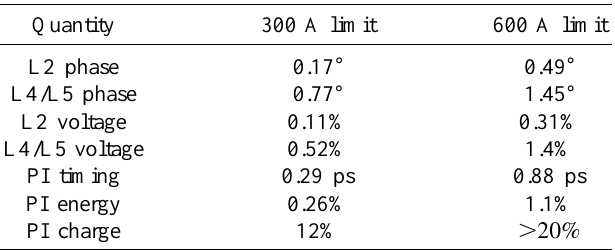
FIG. 6. (Color) Precompressor linac phase deviation limits for acceptable performance as a function of R 56 . TABLE IV. Selected sweep limits for R 56 (cid:1) 2 65 mm.